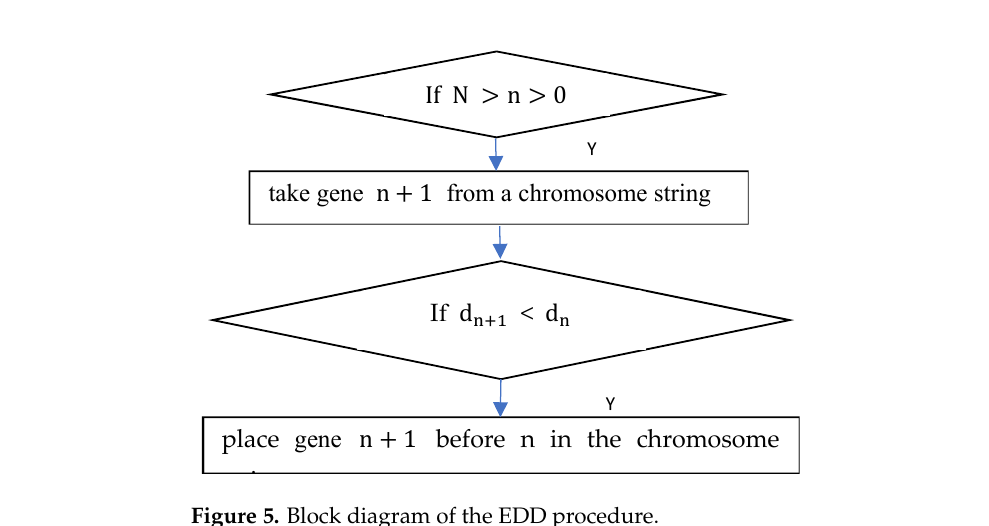
Figure 4. Block diagram of the LPT procedure, where t (cid:2922),(cid:2924) is the operation time of task n executed on machine l.